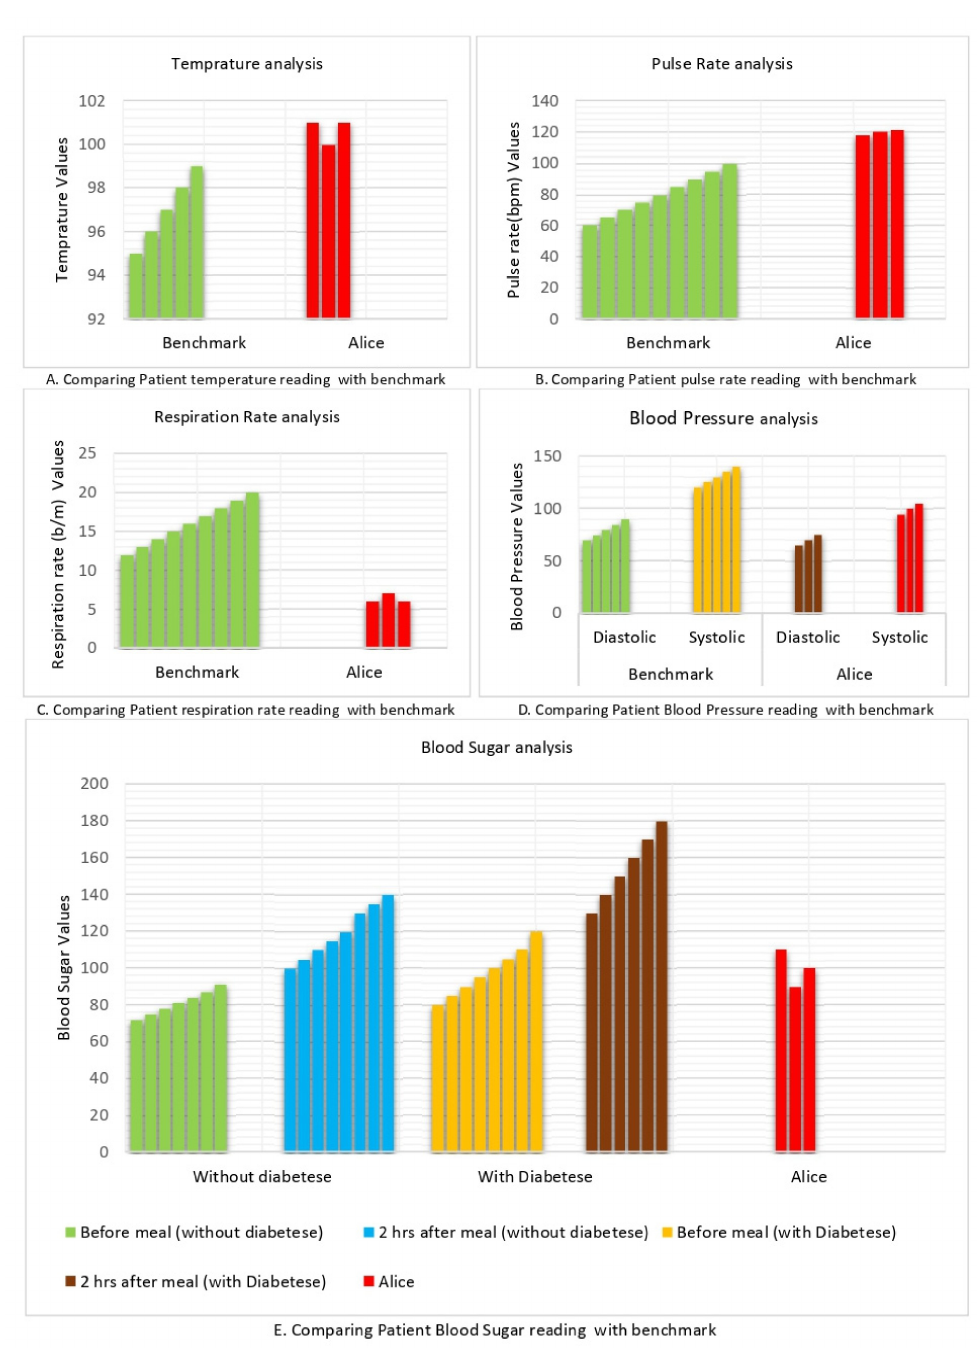
Figure 6. Handling chronic aged patient using proposed multi-agent